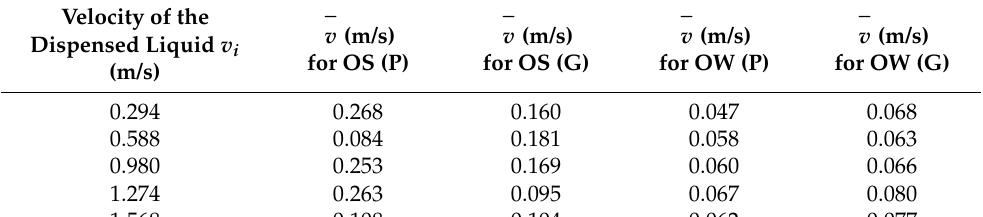
Table 2. The average size of the vector of the instantaneous particle velocity in the selected area for the tested cross-sections in the front (P) and top (G) view of the OS and OW apparatuses.